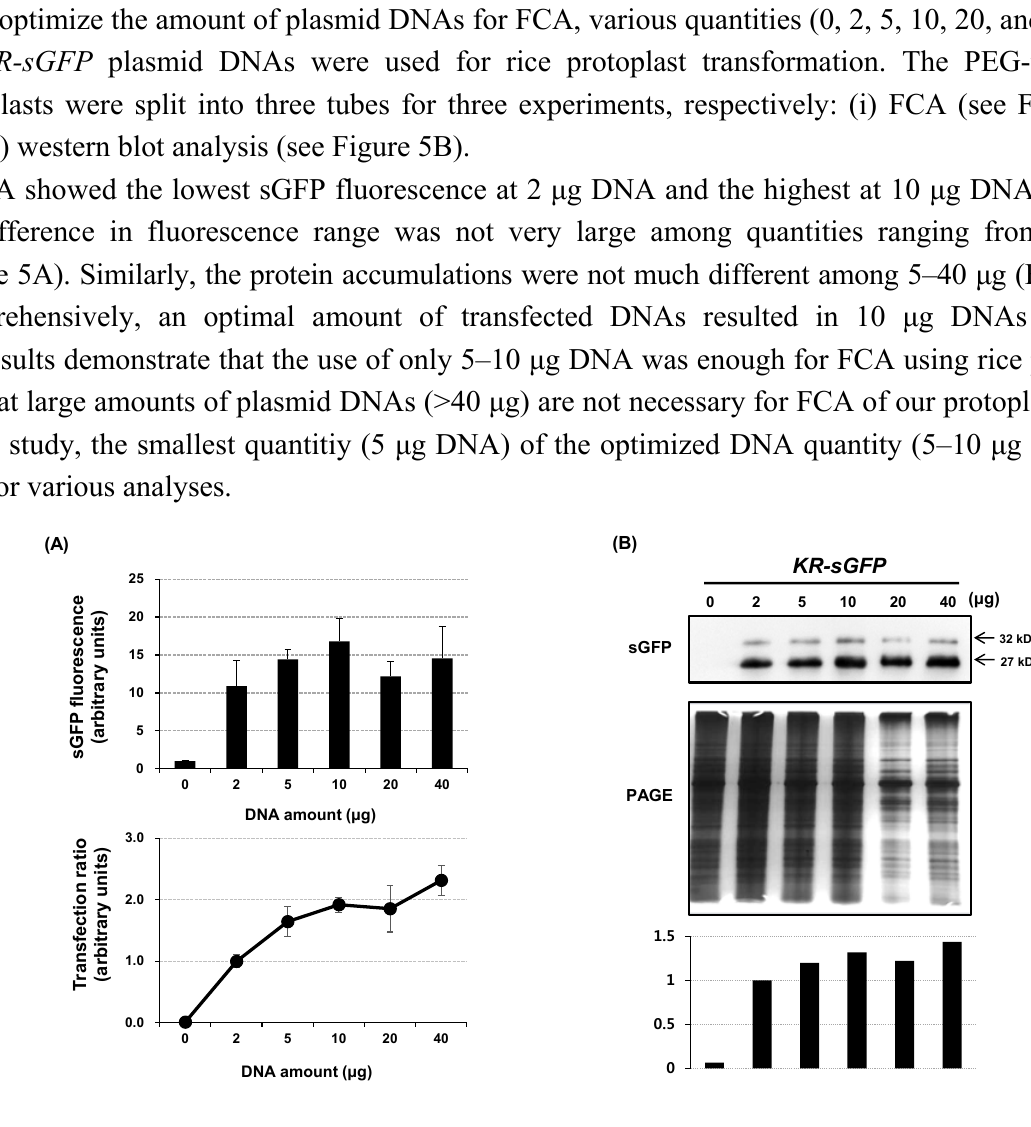
Figure 5. Optimization of the amount of DNA for FCA-based analysis using a KR-sGFP reporter system. The fluorescent signals exceeding the gating threshold were detected in single live protoplasts. ( A ) The sGFP fluorescence was detected using the FITC-A channel of the flow cytometer and its values were normalized by the fluorescent intensity of the protoplasts transfected using 0 μg DNA. The results are presented in arbitrary units. to total protoplasts gated by side scattering and forward scattering procedure on